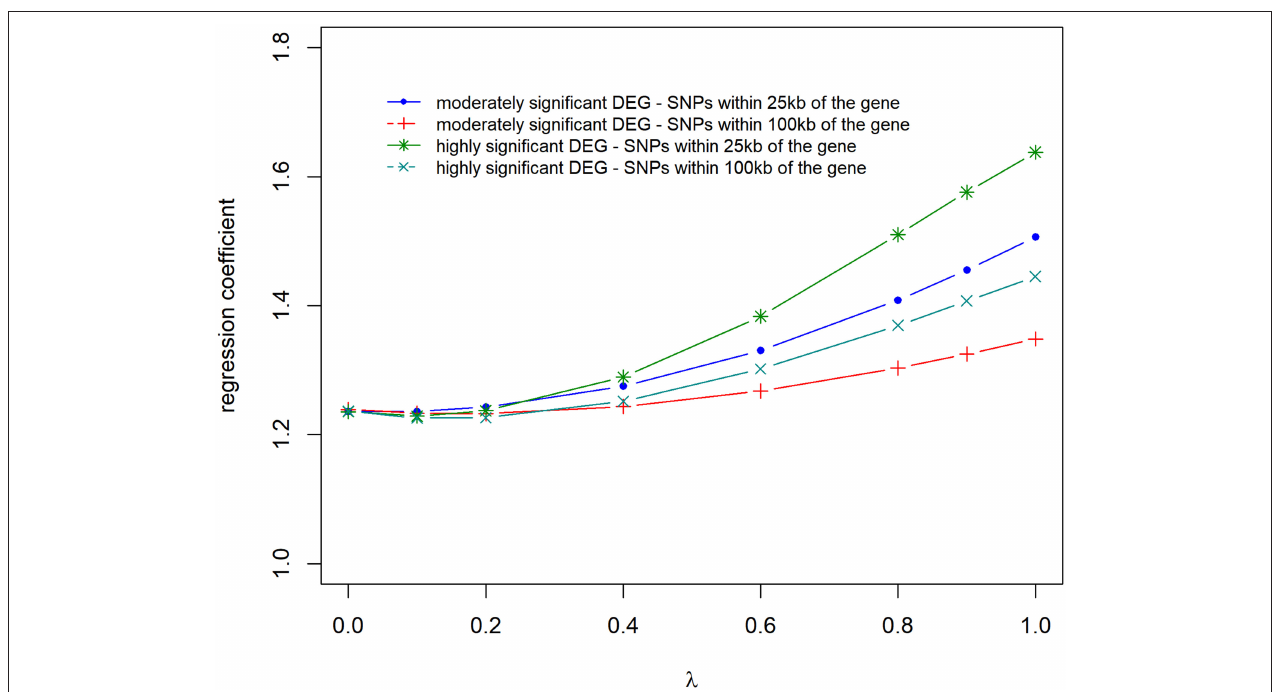
FIGURE 7 | Regression coefficient of adjusted phenotype on genomic breeding values for different λ (blending of two genomic relationship matrices) values. The two genomic relationship matrices were generated for SNPs that were either within significant genes in gene expression analysis or not. Markers within significant DE genes were also weighted with the log 2 1 F of that